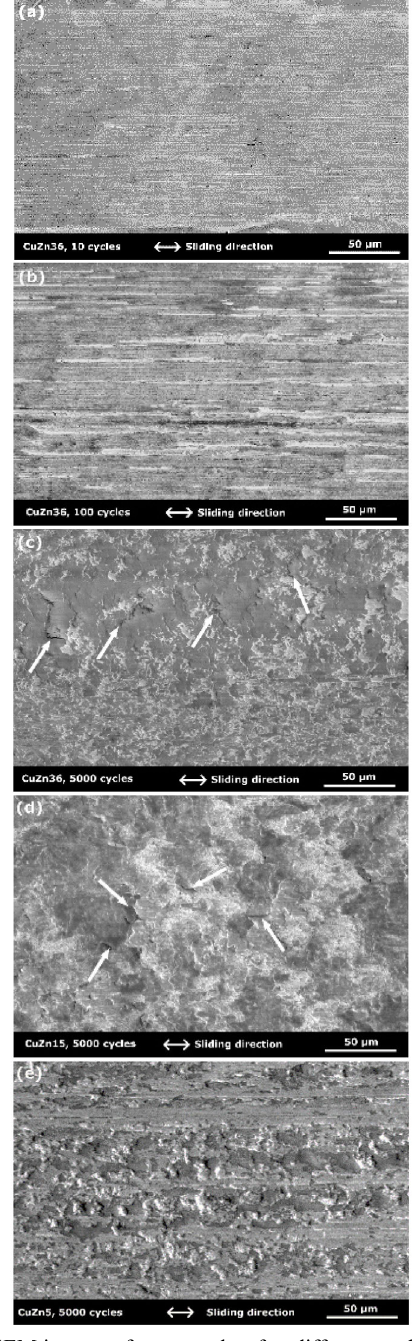
Fig. 3 SEM images of wear tracks after different cycle numbers and for different  -brass samples illustrating the evolution of the wear tracks. (a) CuZn36 after 10 cycles, (b) CuZn36 after 100 cycles, (c) CuZn36 after 5,000 cycles, (d) CuZn15 after 5,000 cycles, and (e) CuZn5 after 5,000 cycles. (a) The entire width of the wear track is visible in the image; while (b–e) the wear tracks are so wide that the images were taken inside the wear tracks. The sliding direction is horizontal for all images and marked by white double arrows. Flake-like wear particles and delamination events are marked by the white arrows in (c) and